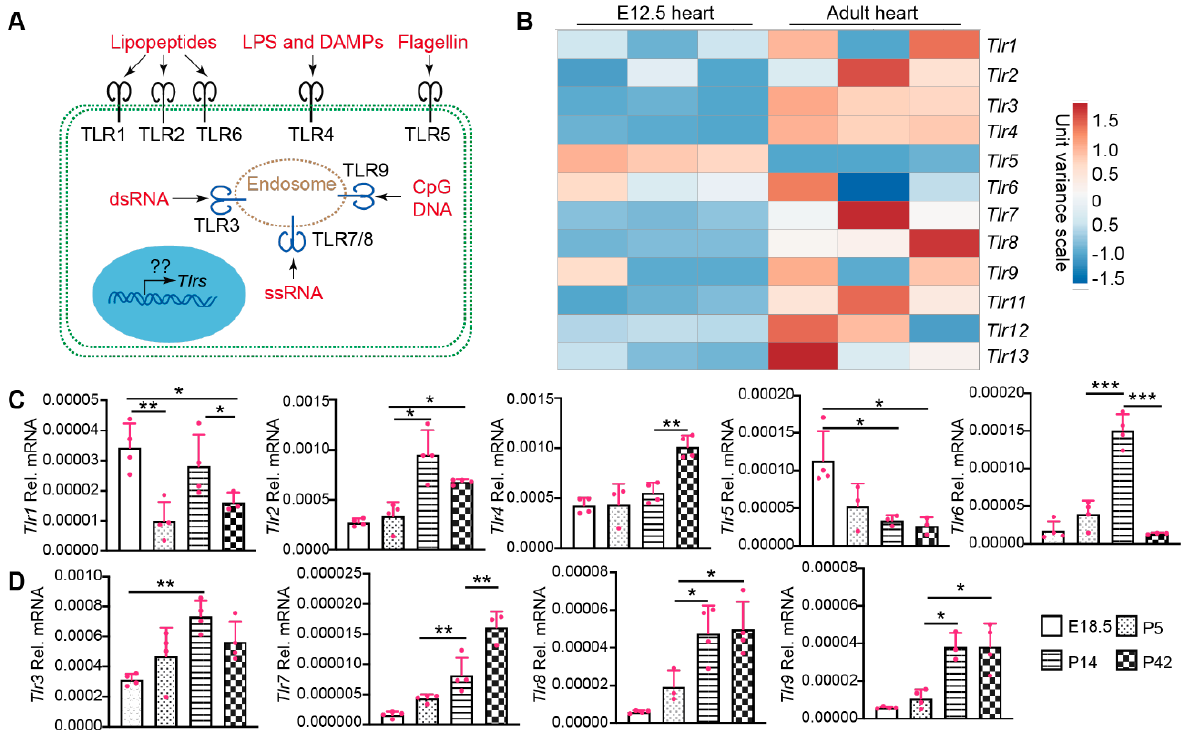
Figure 1. The expression of TLR genes in different age hearts. ( A ). Schematic view of TLR cellular localization and ligands. TLR1, 2, and 6 recognize bacteria- or mycoplasma-derived lipopeptides. TLR4 recognizes bacteria-derived lipopolysaccharide (LPS) and host-cell-derived death associated molecular patterns (DAMPs). Bacteria-derived Flagellin is the natural ligand of TLR5. Virus-derived double strand RNA (dsRNA) and single strand RNA (ssRNA) binds to and activates TLR3 and TLR7/8, respectively. TLR9 recognizes DNA containing unmethylated CpG motifs prevalent in microorganisms and mitochondrial DNA, but not in vertebrate genomic DNA. On the transcriptional level, mechanisms regulating the expression of these TLR genes are largely unknown. ( B ). Heat map of TLR gene expression levels in fetal and adult hearts. TLR gene expression values were retrieved from published RNA seq data (22). The heat map was generated with an online tool (ClustVis). ( C , D ). qRT-PCR measurement of TLR genes during heart development. Total RNA from hearts with the indicated ages was used for qRT-PCR. Gene expression level was normalized to Gapdh . E18.5, embryonic day 18.5; P5, P14, P42, postnatal days 5, 14, and 42. One-way ANOVA post hoc Tukey’s multiple comparisons test, *, p < 0.05; **, p < 0.01, ***, p < 0.001. n = 4.